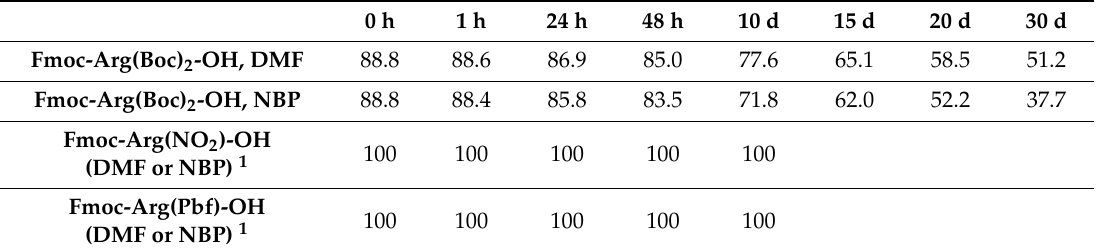
Table 1. Stability of Fmoc-Arg(X)-OH in DMF ( N,N- dimethylformamide) and NBP ( N- butylpyrrolidone) at room temperature.